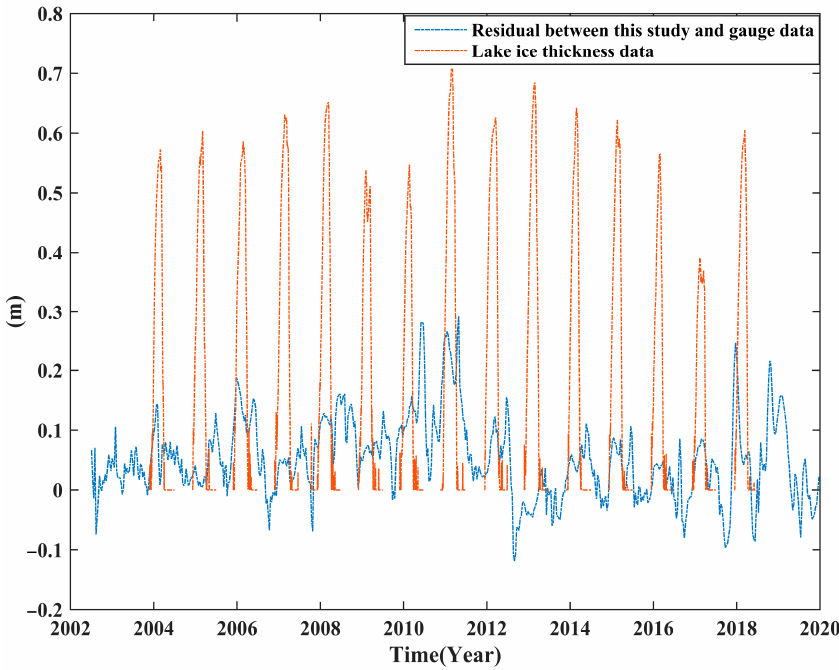
Figure 13. Comparison of residual errors of the results of this paper with the observations at the lower stations and the results of ice thickness